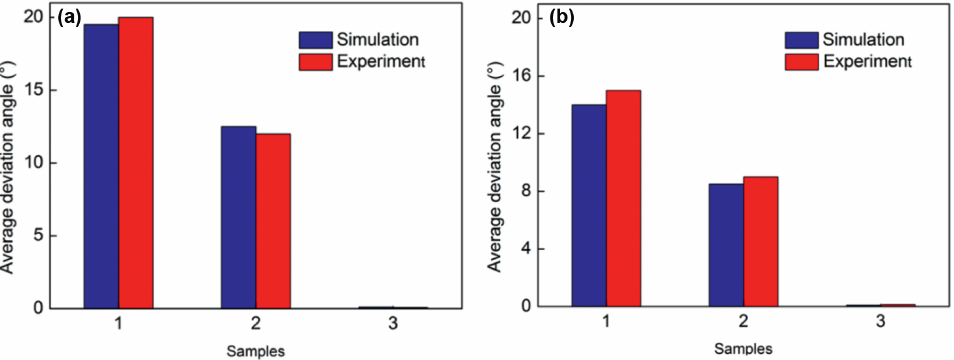
Figure 9: Simulation and experimental results of the average deviations angles: (a) HRS and (b) LMC